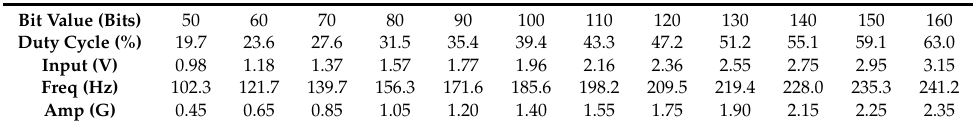
Table A1. Vibration parameters as the related input voltage. Frequency and amplitude are reported from the manufacturer specification sheet [30].